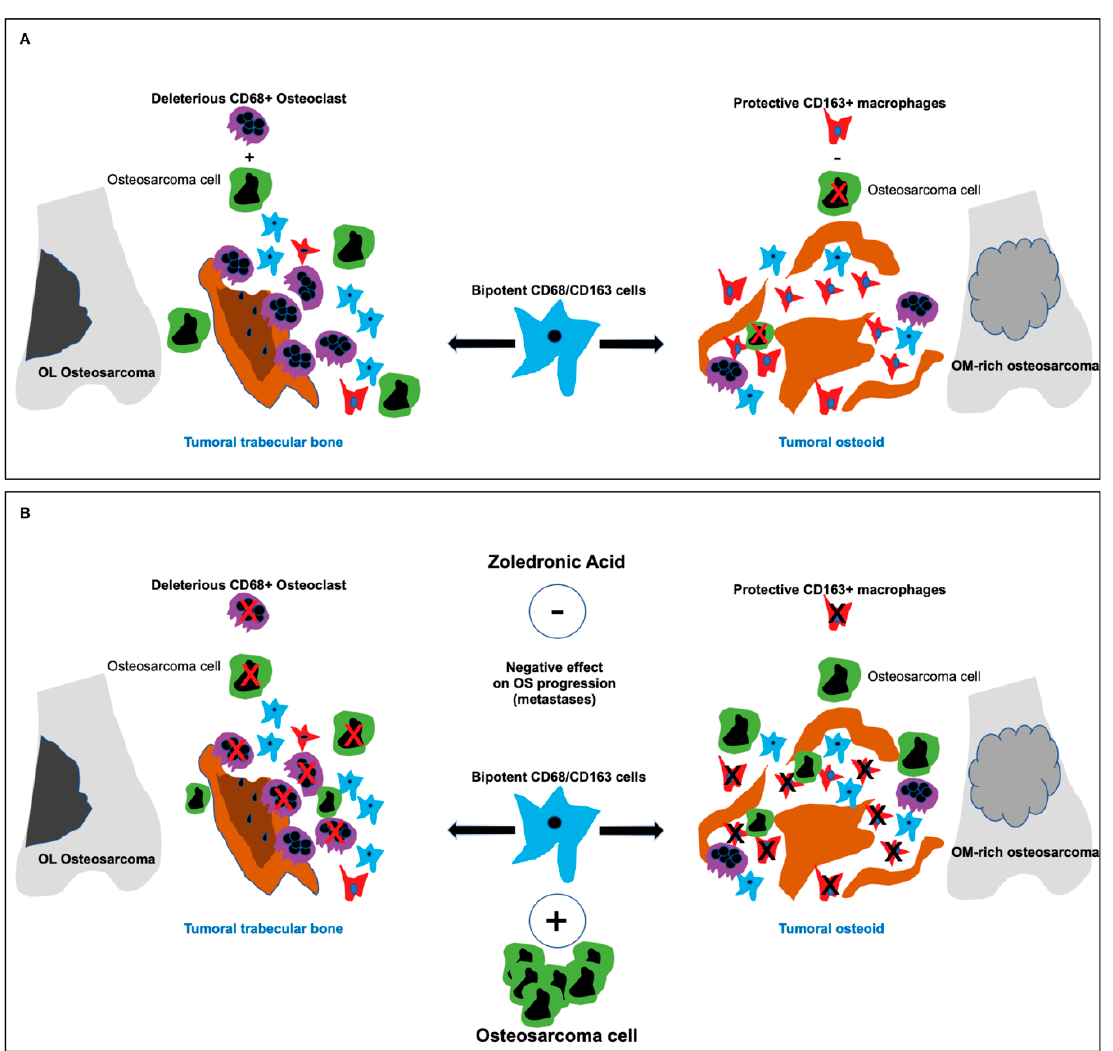
Figure 5. ( A ) The imbalance of osteoclasts, macrophages and bipotent cells involved in tumoral bone remodeling in Osteosarcoma. ( B ) Inhibitory effect of zoledronic acid (ZA) on both deleterious CD68+/CD163 − osteoclasts and protective CD68 − /CD163+ macrophages in Osteosarcoma.